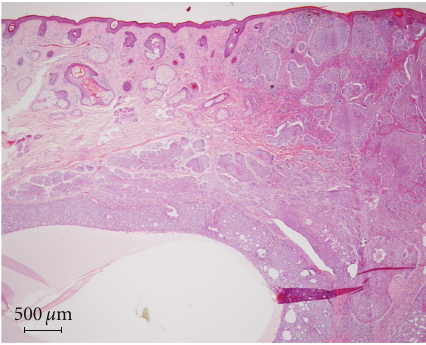
Figure 4: Histological examination showed multiple variably sized nodules with continuation of the epidermis. A cystic area underlies the tumor masses.